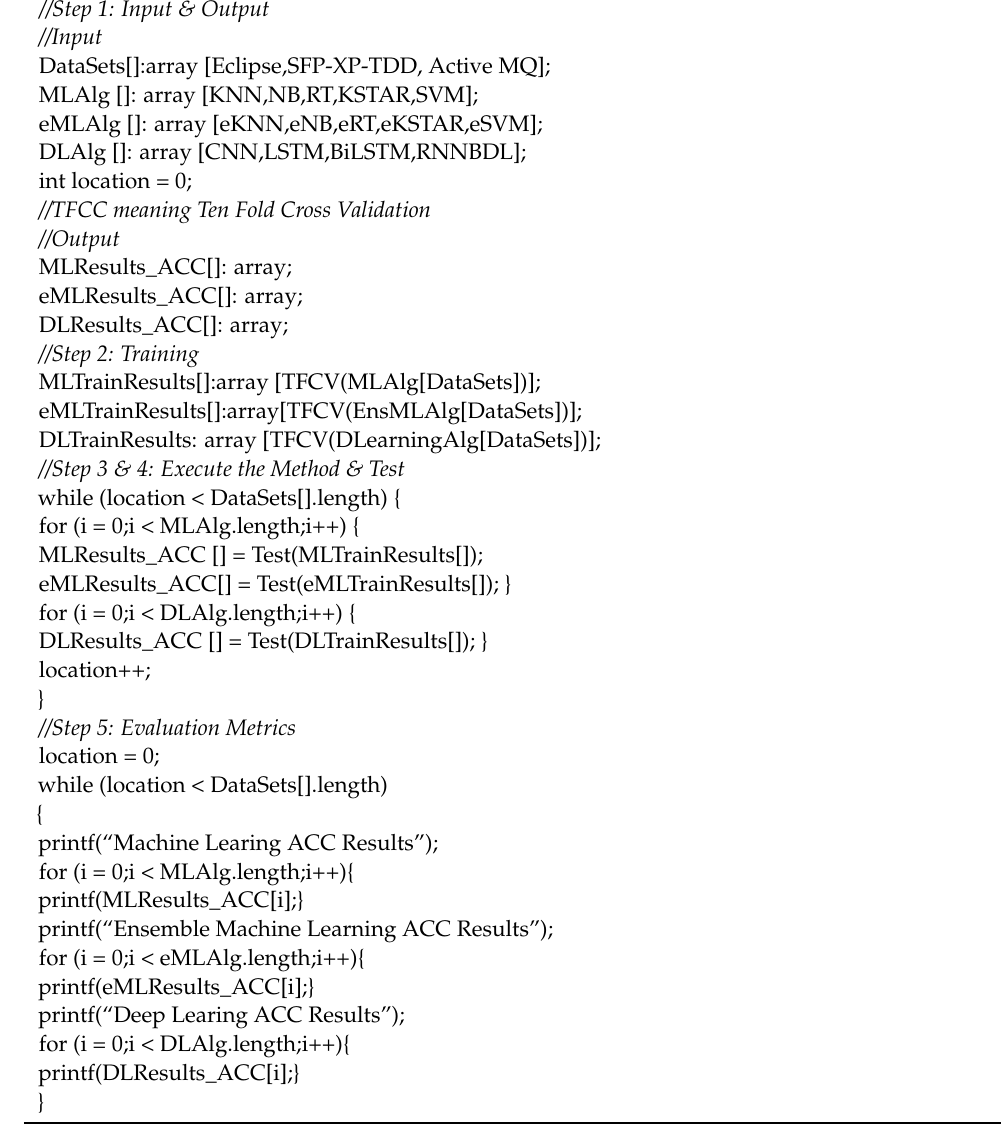
Algorithm 1. Pseudo-code of the proposed scheme.